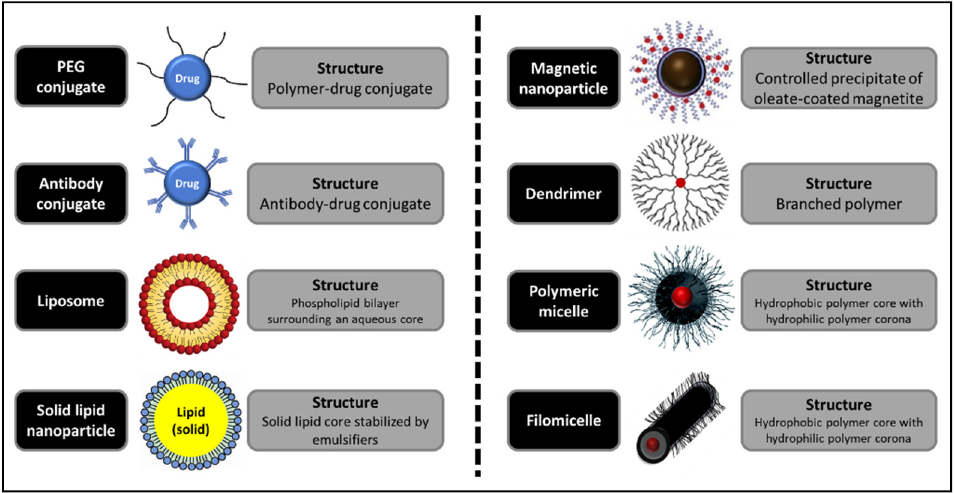
Figure 1. Schematics of the common classes of